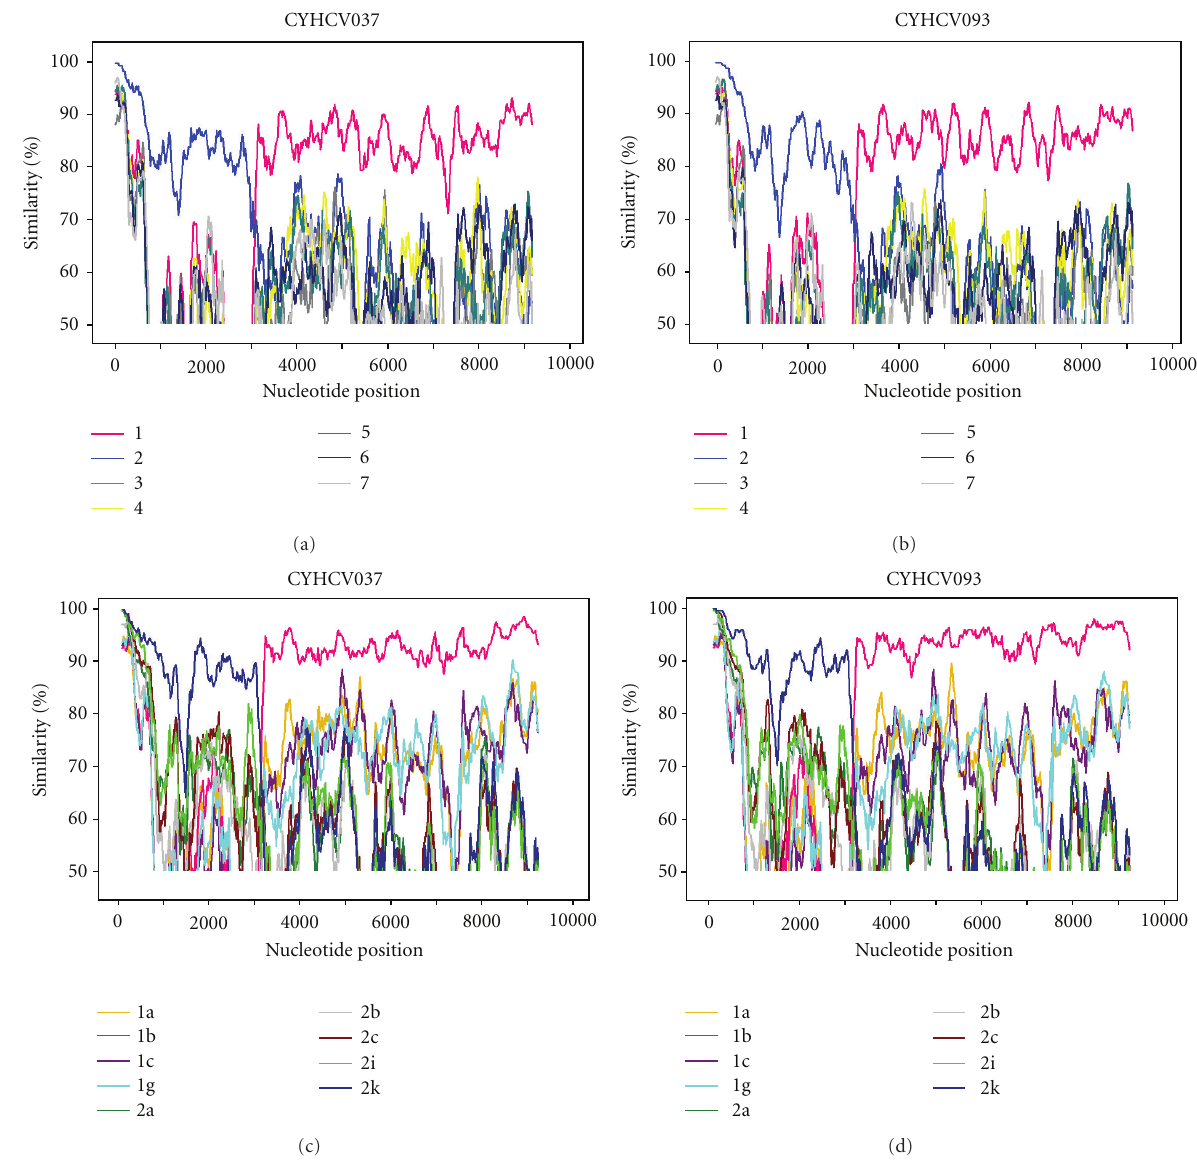
Figure 1: Simplot analysesof the two 2k/1b recombinant candidate strains, showingpercentage sequence similarity over nucleotide position. (a, c) are for strain CYHCV037, and (b, d) for strain CYHCV093. The plots on the top are the results of a genotype-level analysis, with genotypes corresponding to line colours annotated below the plots. The bottom plots are the results of a subtype-level analysis, once the genetically closest parental genotypes had been determined using the top plots. The subtypes corresponding to the coloured lines are annotated below the